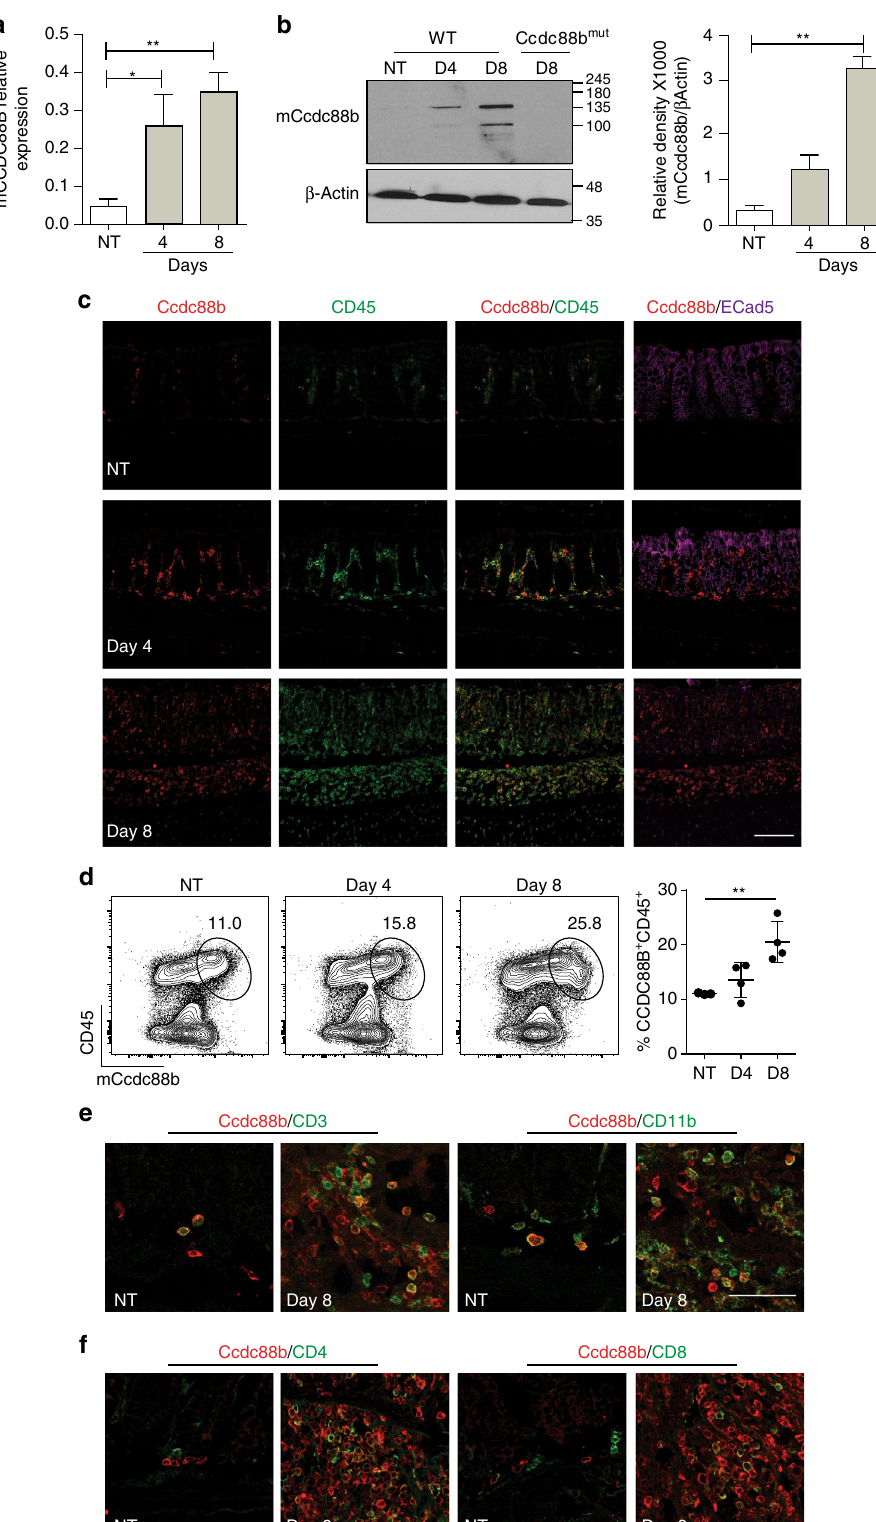
Crohn ’ s disease (CD) the ileum and colon are primarily affected, whereas in ulcerative colitis (UC) only the distal colon is affected. Both genetic factors and environmental effects (life